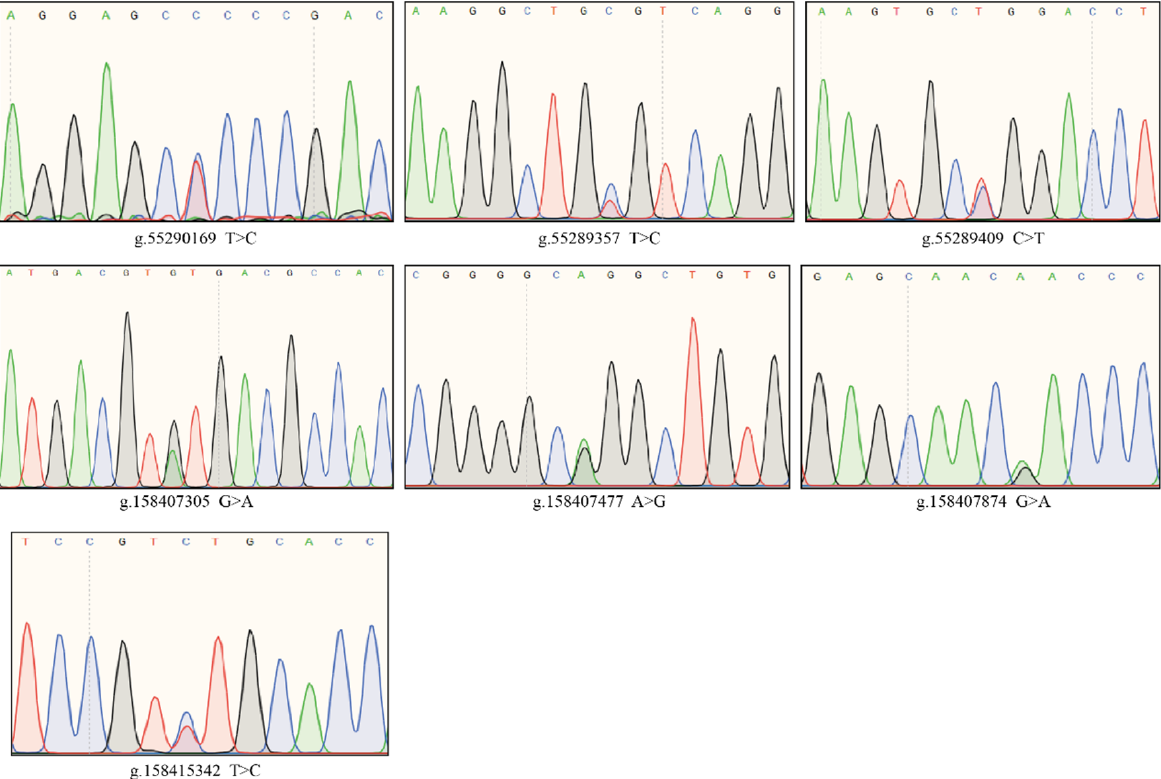
Figure 2. The sequence chromatograms of the heterozygous genotypes.